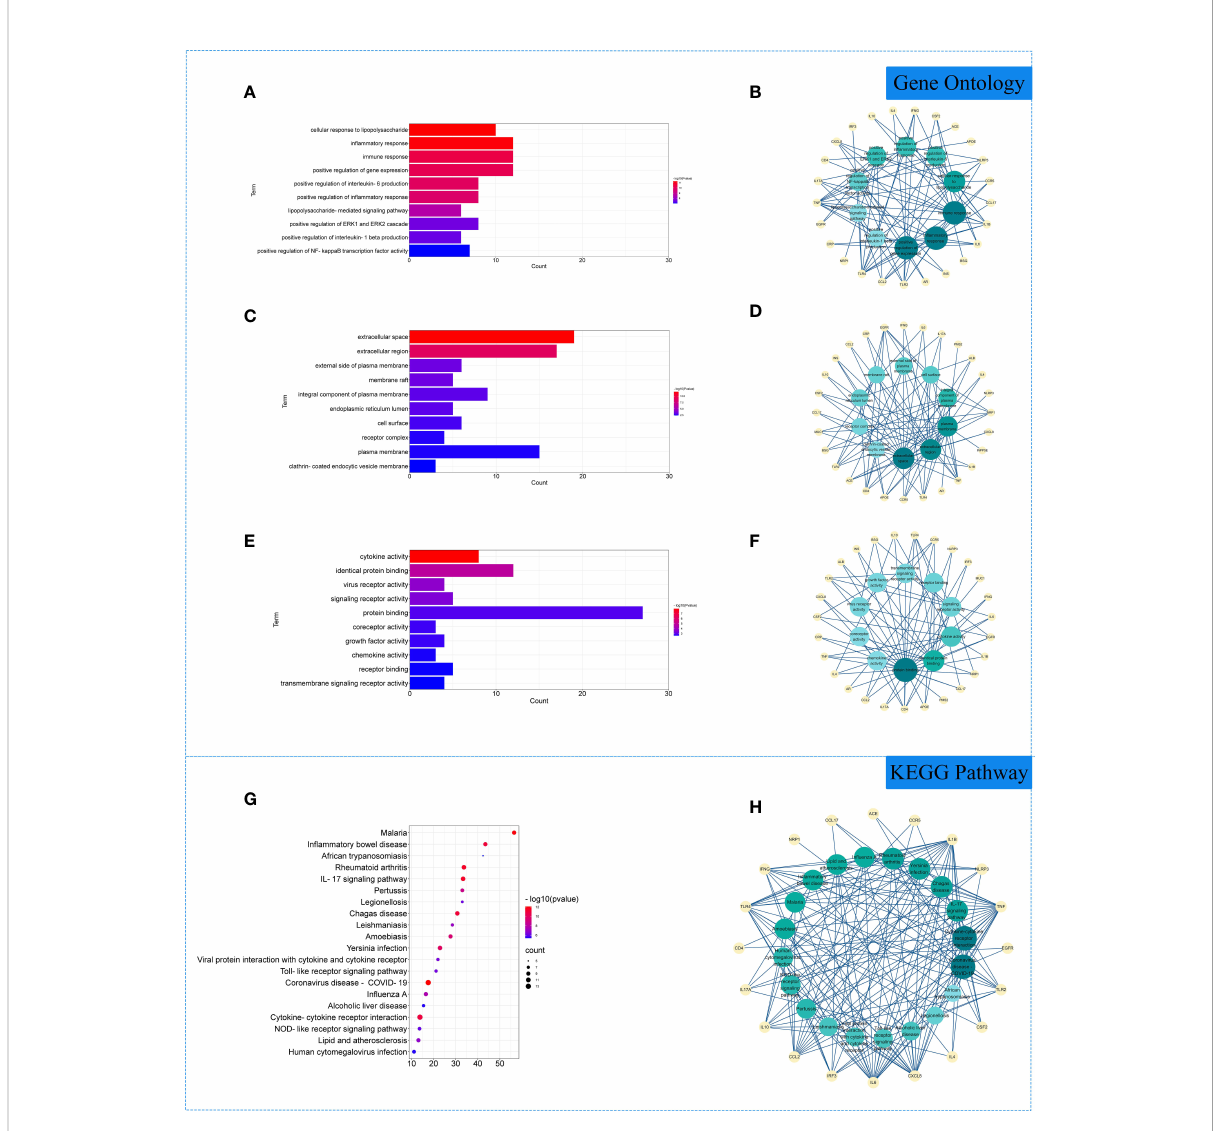
FIGURE 3 Gene Ontology (GO) and Kyoto Encyclopedia of Genes and Genomes (KEGG) analysis of related genes. (A) The top 10 terms in biological processes (BP) were greatly enriched. (B) The subnetwork displayed the top 10 BP terms and related genes. (C) The top 10 terms in cellular components (CC) were greatly enriched. (D) The subnetwork displayed the fi rst 10 CC terms and related genes. (E) The top 10 terms in molecular function (MF) were greatly enriched. (F) The subnetwork displayed the top 10 MF terms and related genes. (G) The top 20 KEGG pathways were showed. (H) The subnetworks displayed the top 20 KEGG pathways and